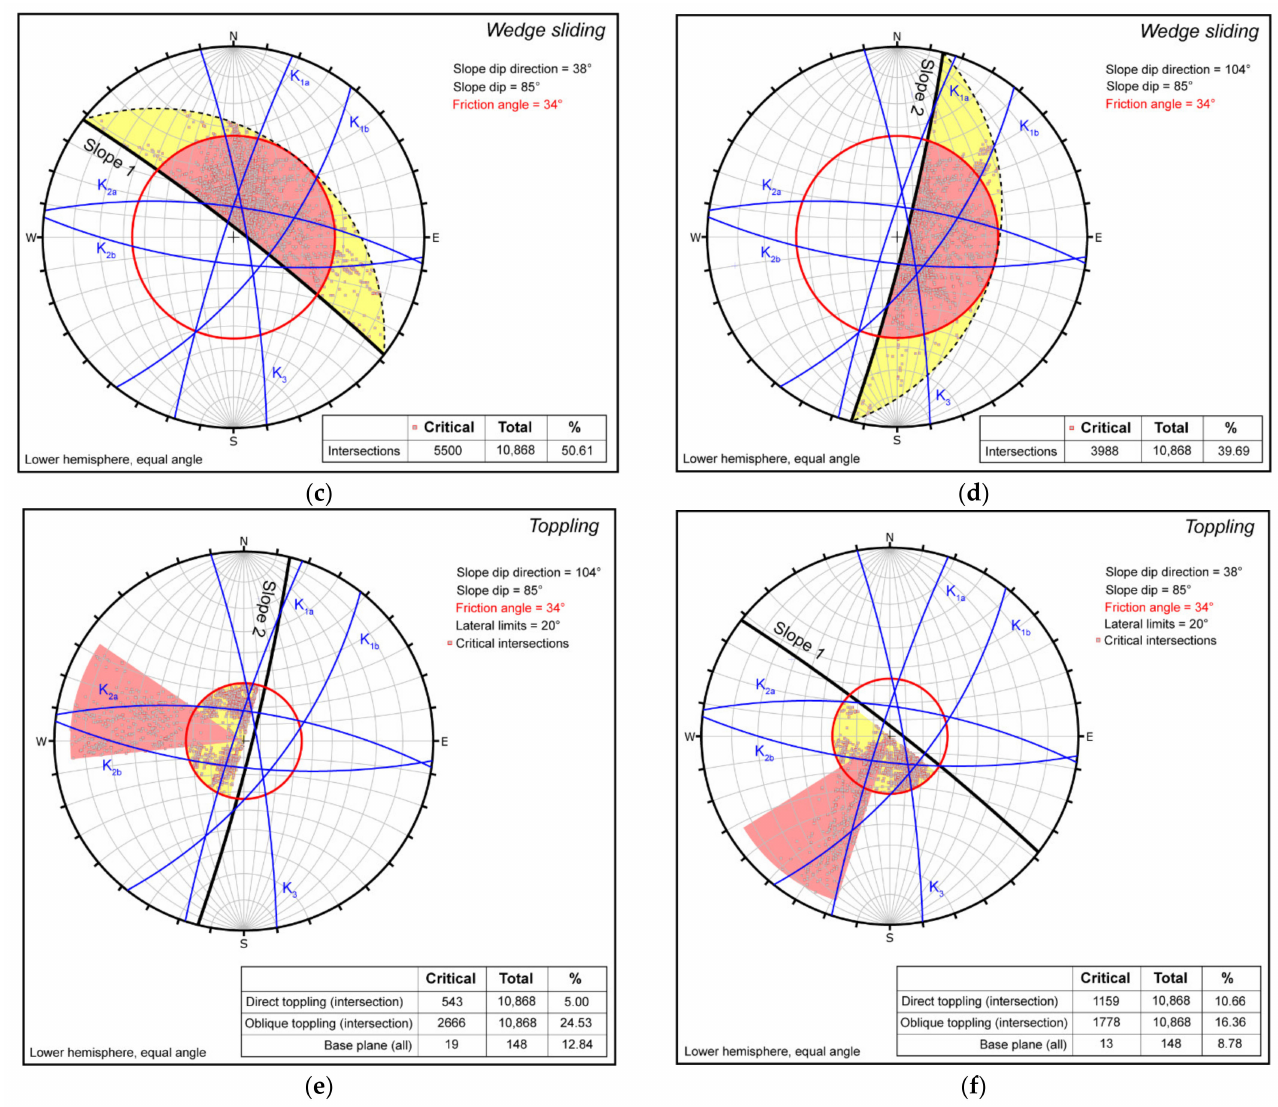
Figure 10. Stereographic equal angle plots (lower hemisphere) with the critical zones (red and yellow areas) for failure mode. ( a ) Planar sliding for Slope 1; ( b ) Planar sliding for Slope 2; ( c ) Wedge sliding for Slope 1; ( d ) Wedge sliding for Slope 2; ( e ) Direct and oblique toppling for Slope 1; ( f ) Direct and oblique toppling for Slope